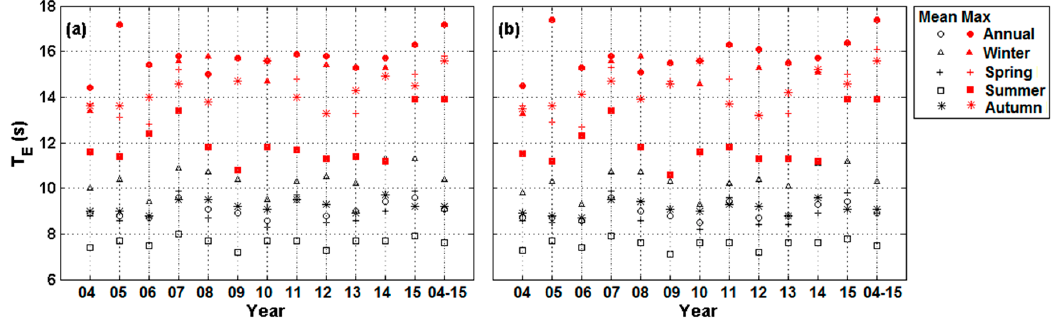
Figure 13. Summary statistics from annual and seasonal analyses of T E (s) for mean and maximum ( Max ) at ( a ) BA and ( b ) BB.